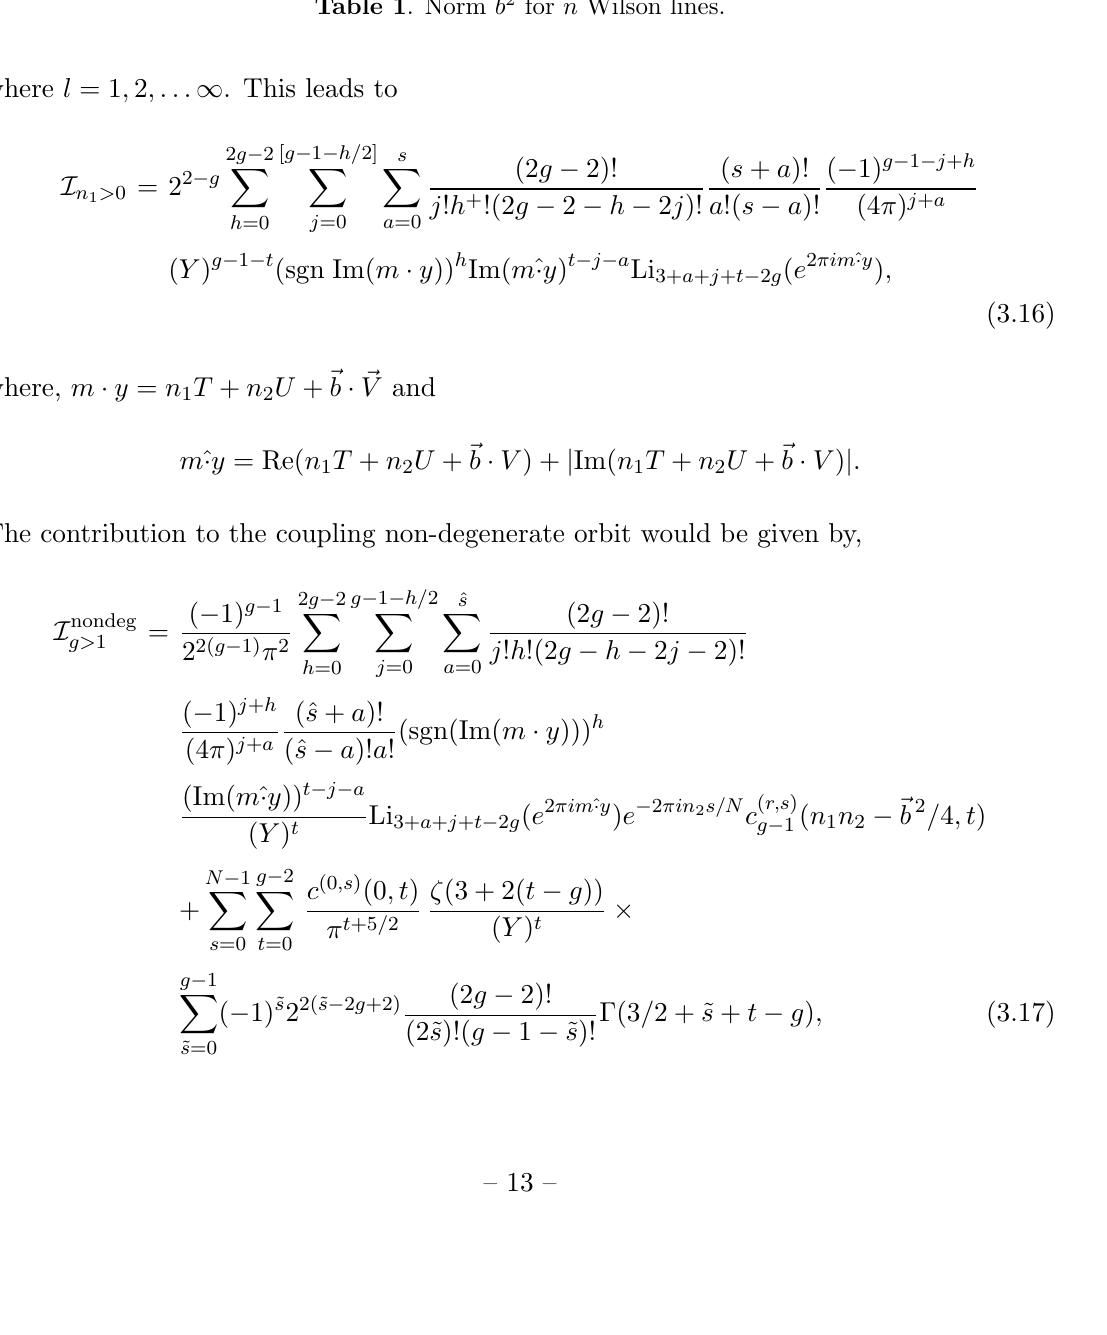
Table 1 . Norm b 2 for n Wilson